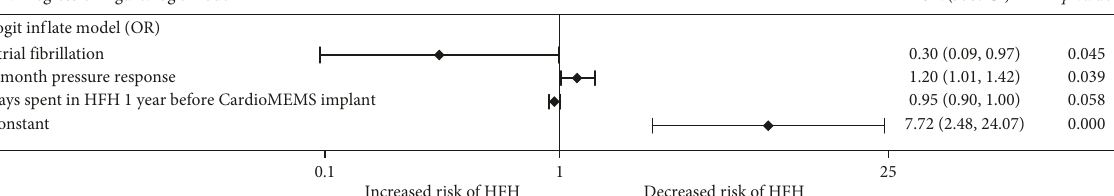
Figure 3: Forest plot illustration of the logit model component of the zero-inflated negative binomial model. Regression coefficients and 95% confidence intervals are presented as odds ratios. The 1-month pressure response is defined as the difference in mean pulmonary artery diastolic pressure between the first and second two weeks following sensor implantation (PADP ratio (OR) > 1 indicates increased probability of having zero HFHs, and an OR < 1 indicates increased probability of having HFHs. The constant term indicates the y -intercept of this model and can be interpreted as the odds of having zero days spent in HFH if the value of all the independent variables could be set to zero. ZINB: zero-inflated negative binomial; OR: odds ratio; CI: confidence interval; HFH: heart failure